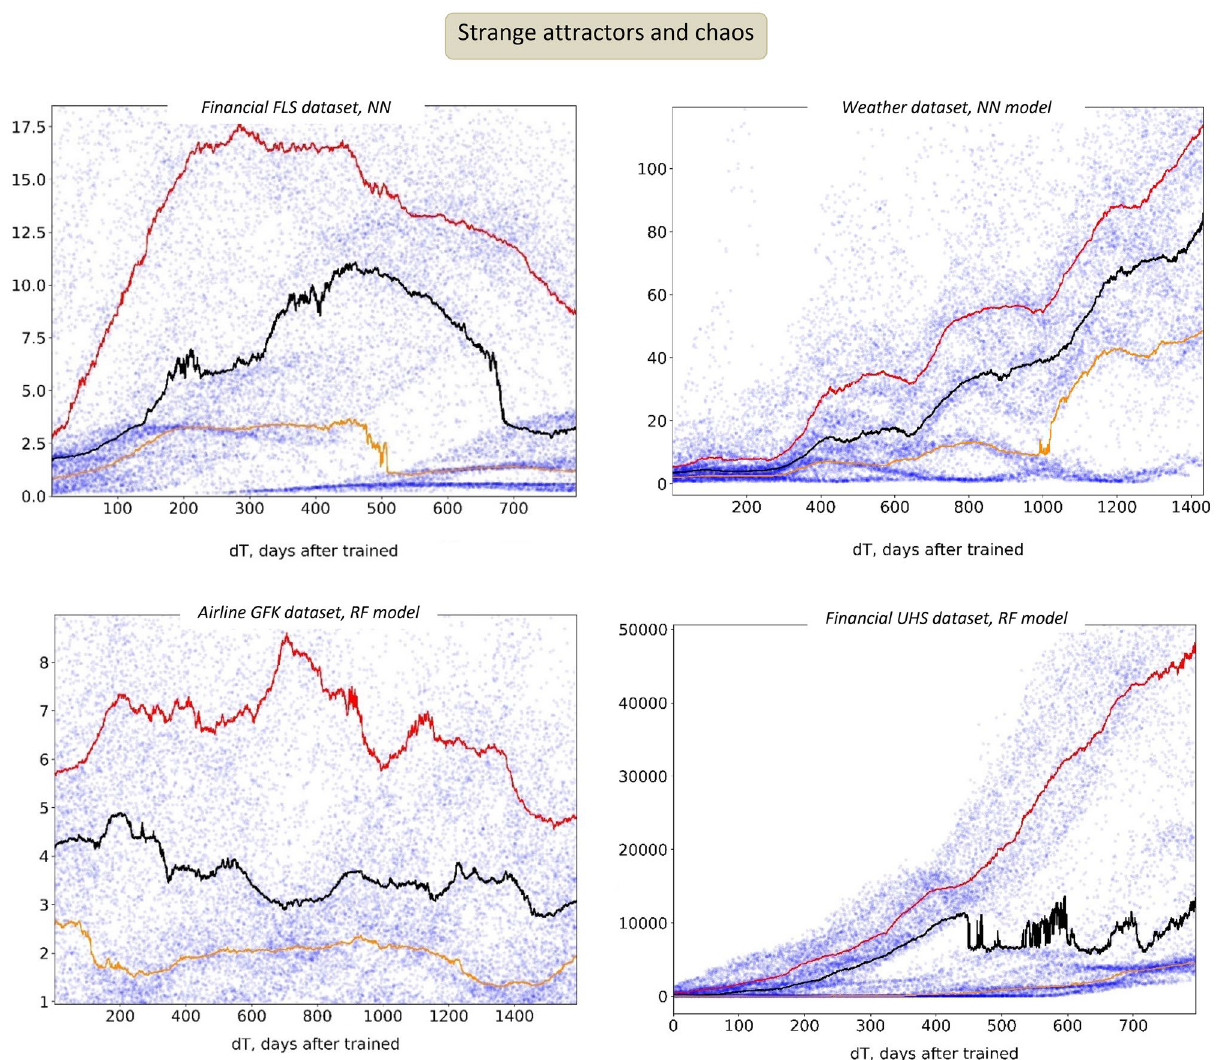
Figure 4. Strange attractors, as dense areas of most probable errors, in temporal model